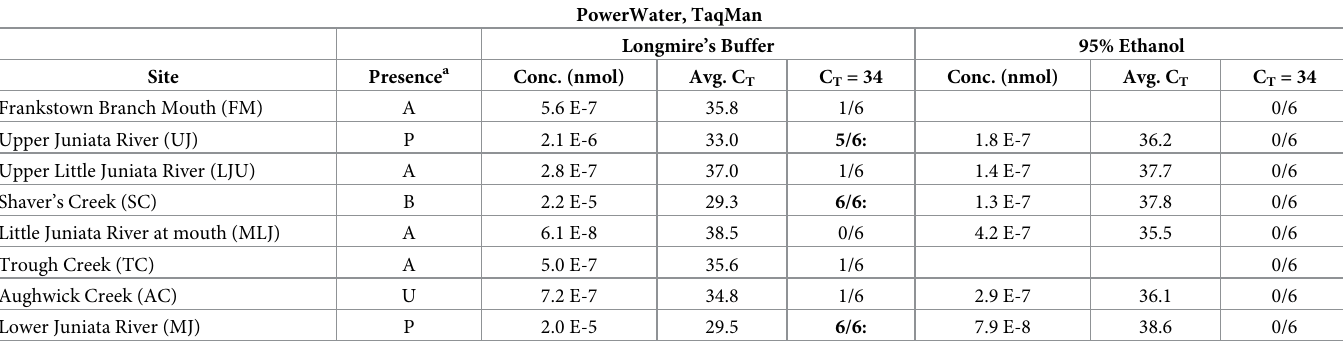
Table 3. Qiagen’s PowerWater extraction kit with a TaqMan qPCR